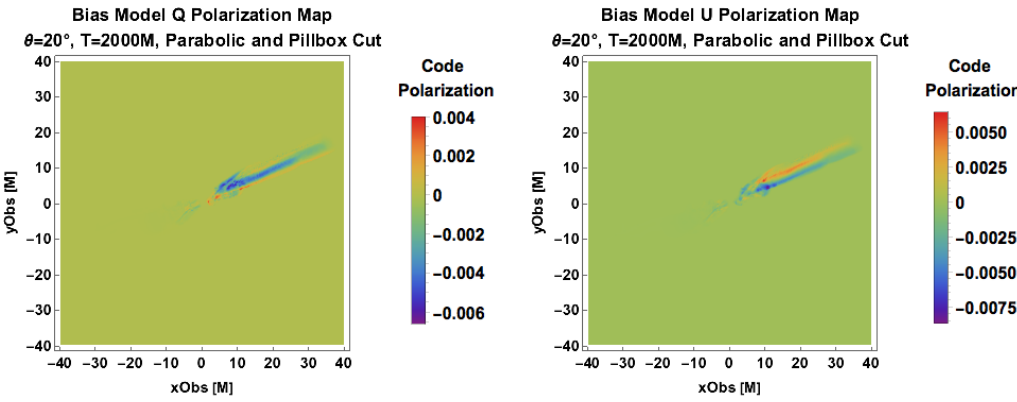
Figure 5. Linear polarizations Q ( left ) and U ( right ) maps at a 20 ◦ viewing angle generated from the emissivity function j ∼ ( b µ b µ ) 3 4 and parabolic geometric jet region